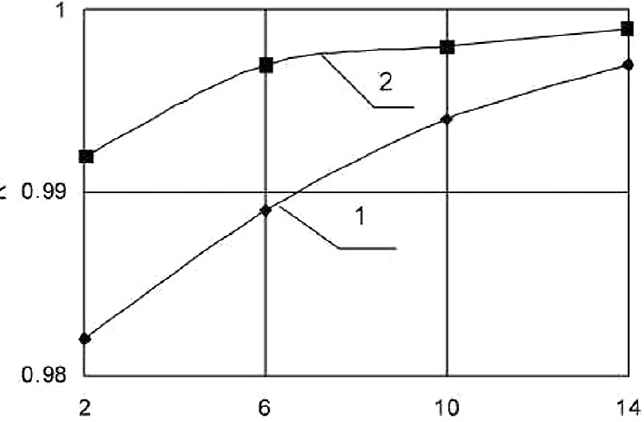
Figure 4. Dependence of the failure-free operation probability on the holding time under pressure PP 21060-16 and the casting temperature at a casting pressure of 80 MPa: (1) 270; (2) 200 ° С . In this way, the real curves of changes in the reliability level of the polymer material were obtained, which depend on two parameters: the holding time under pressure and the material temperature.